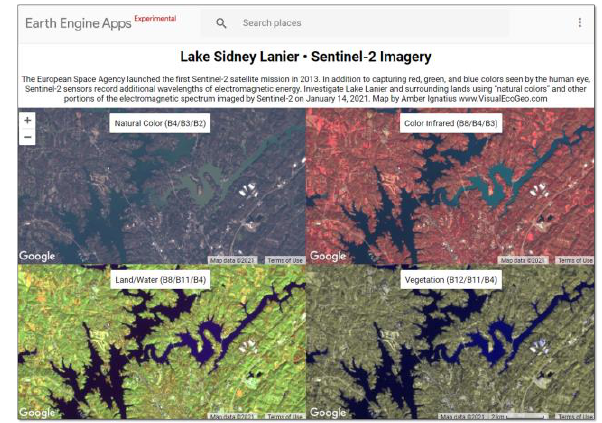
Figure 3. Google Earth Engine map application for Sentinel-2 band combination comparison of Lake Sidney Lanier.